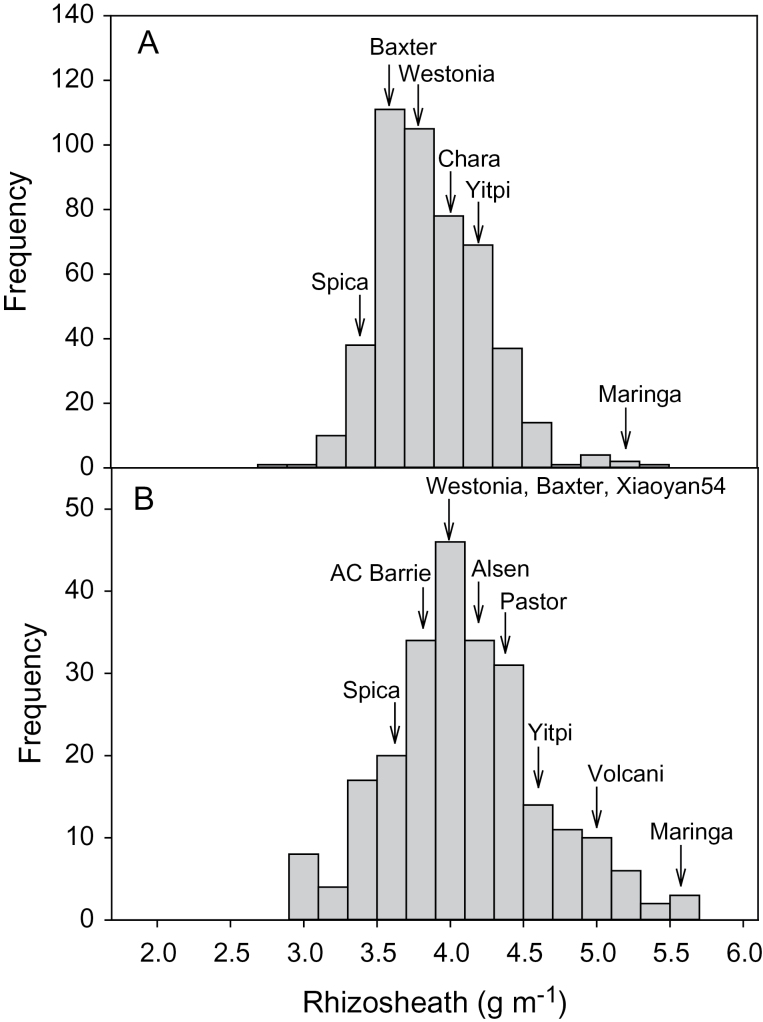
Frequency distributions of rhizosheath size for 466 lines of the 4-way (A) and 230 lines of the 8-way (B) MAGIC populations. The rhizosheath categories of parental and check lines are indicated by the arrows. Data are presented as the number of lines in each rhizosheath size category incrementing by 0.2g m–1 (the values for each line is the mean of n=4–6 seedlings).